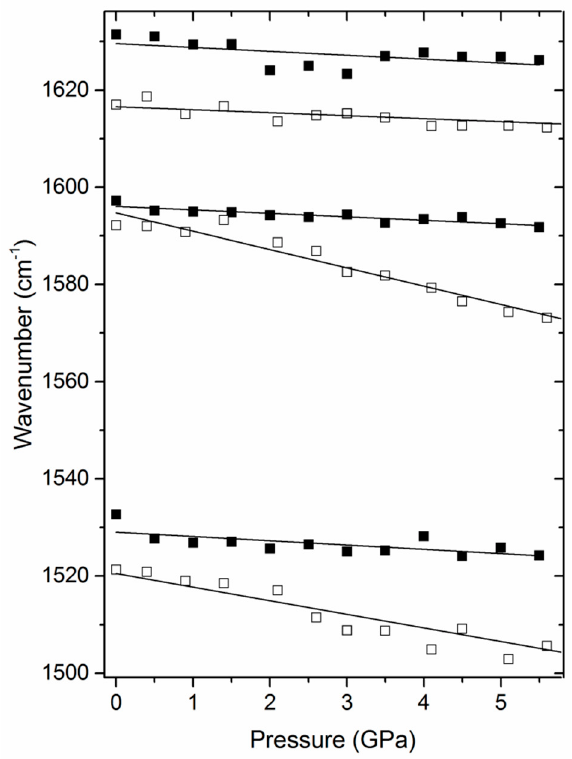
Figure 3. Wavenumber of the mode associated with bending of NH 3 + as a function of pressure for monoglycine nitrate (full symbols) and mono- L -alaninium nitrate (empty symbols).